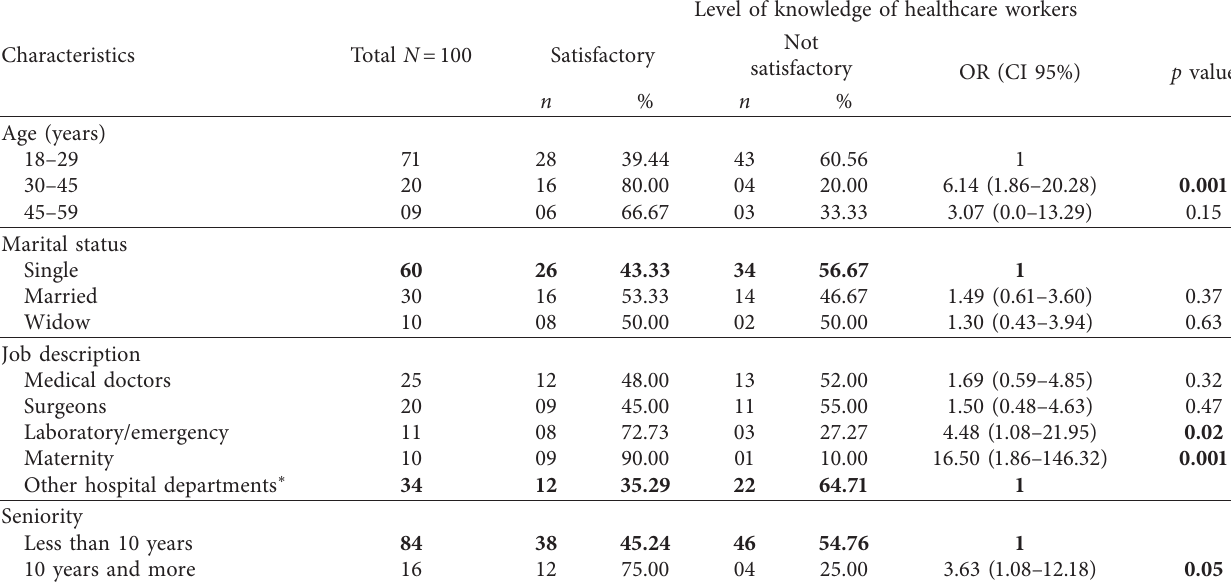
Table 3: Relation between knowledge and the sociodemographic and professional characteristics of healthcare workers.